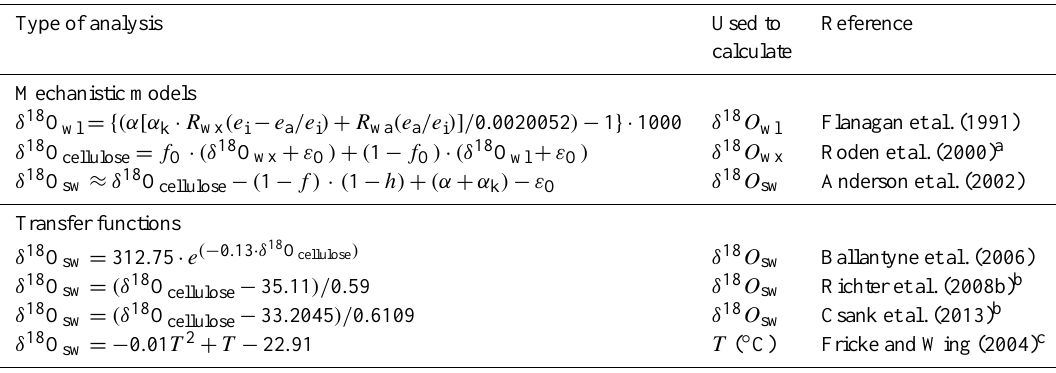
Table 1. Summary of equations used in oxygen isotope temperature reconstruction. Mechanistic models and transfer functions used to predict δ 18 O sw from δ 18 O cellulose , and a temperature– δ 18 O sw relationship developed for the Eocene (Fricke and Wing, 2004). Shown are each equation and the reference on which it is